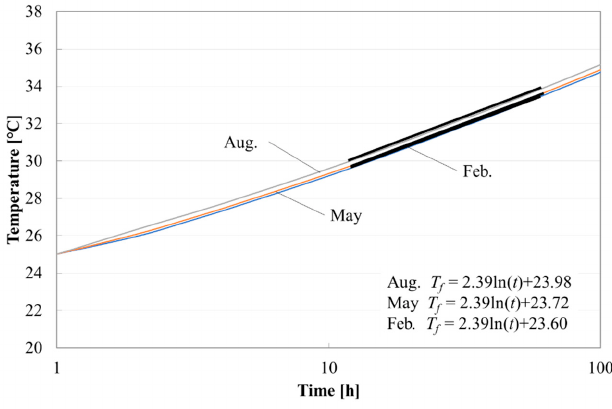
Figure 7. Comparison of temperature variations of heat carrier fluid for each season (20 m). Energies 2020 , 13 , x FOR PEER REVIEW